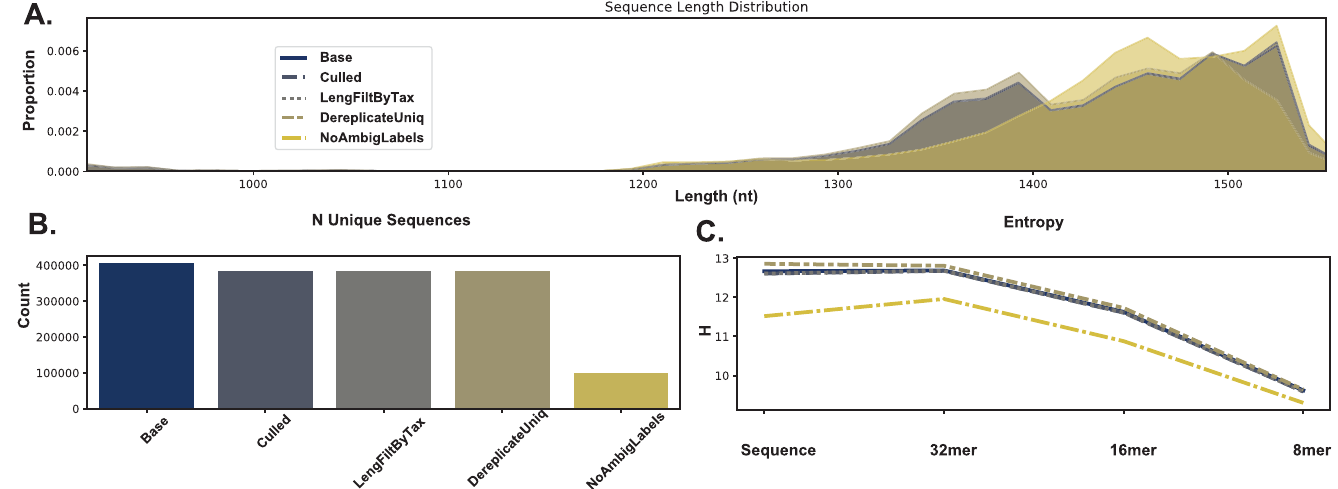
Fig 6. Comparison of sequence information across each successive sequence quality filtering step as applied to the SILVA 16S rRNA gene database. A, Sequence length distributions. B, Number of unique sequences. C, Entropy of full-length sequences and different kmer lengths. Note: The subsequent sequence length filtering did not have any effect on the data as the NR99 reference database is already pre-trimmed as specified above. Base: the complete NR99 SILVA database, Culled: after sequences with either 8 or more homopolymers and/or 5 ambiguous bases removed, LengFiltByTax: sequence length filtering of the data based on taxonomy, i.e. removal of archaeal and bacterial sequences less than 900 and 1200 bp in length, respectively. DereplicateUniq: Taxonomy and Sequence dereplication using “uniq” mode (i.e. any identical sequences with differing taxonomy will not be merged), NoAmbigLabels: any sequence data associated with ambiguous labels (typically at lower taxonomic ranks) are removed from the data set.